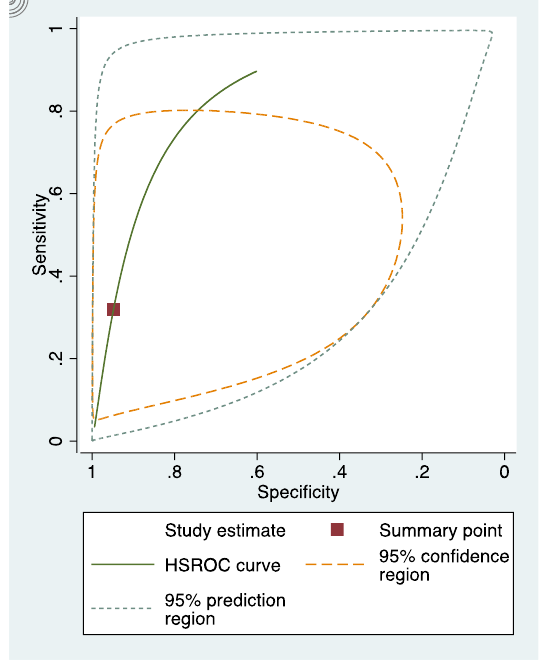
Figure 6. sRoc curves of fluorescence-based methods on occlusal surfaces.